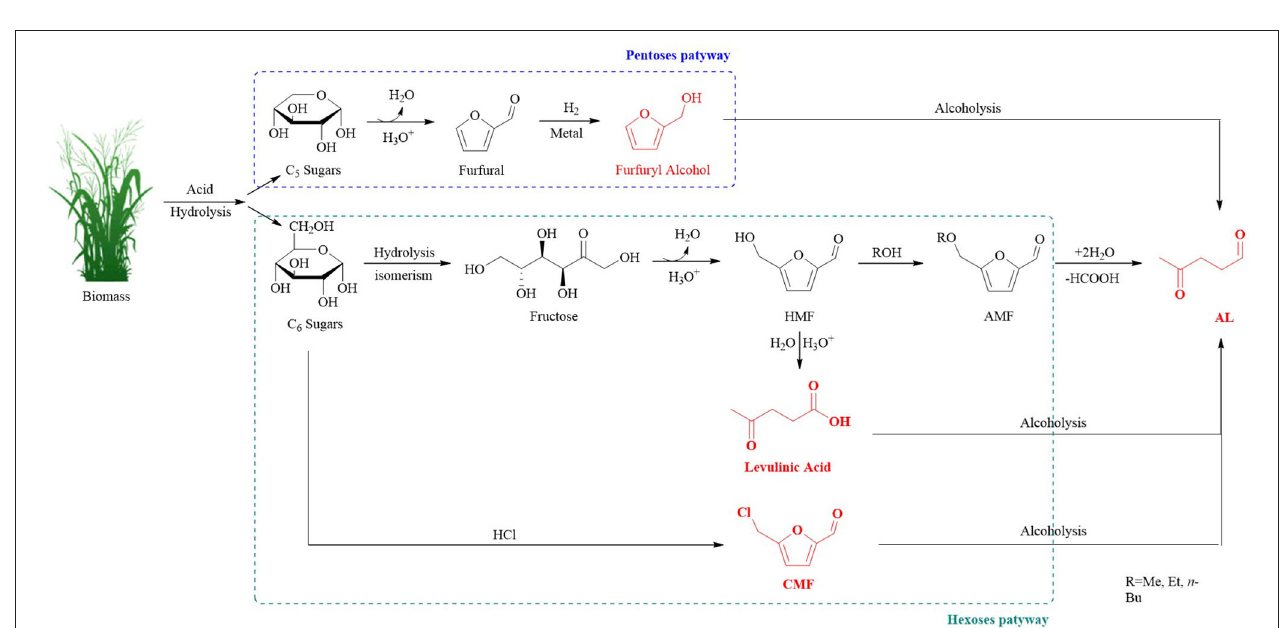
FIGURE 1 | The pathways used for the production of ALs from bio-renewable resources.